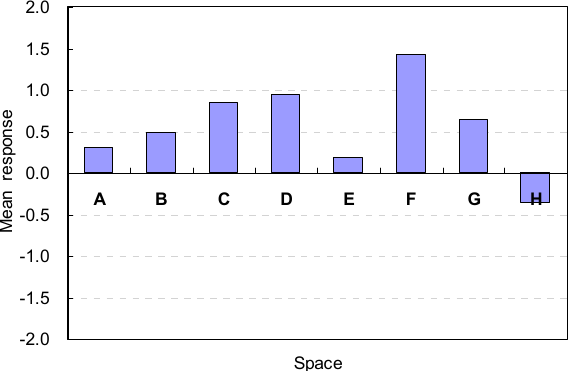
Figure 11. Overall satisfaction of the space in terms of amenity.